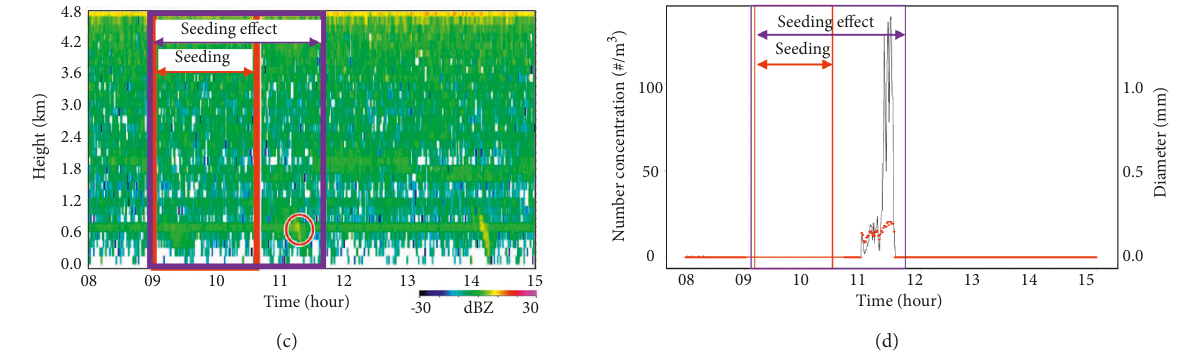
Figure 8: (a) Horizontal distribution of rain detection at 1130 LST, (b) time series of relative humidity (blue), temperature (red), rain (black), cloud top height (green), (c) reflectivity, and (d) number concentration (black) and diameter (red) of raindrop at BOWO from 0800 to 1500 LST on April 25, 2019.